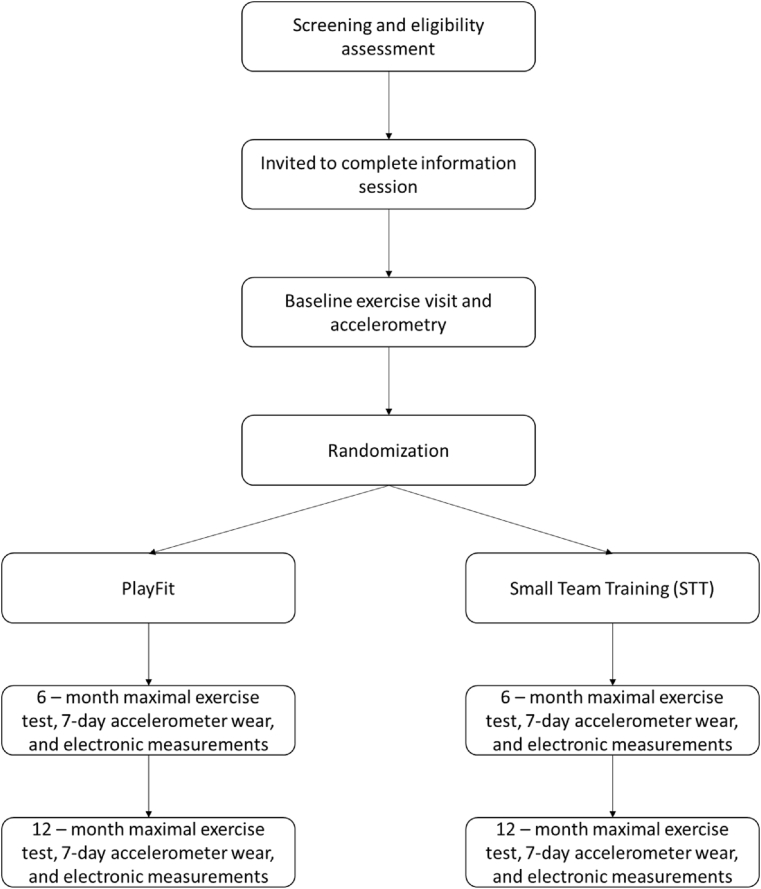
Study flow-chart.